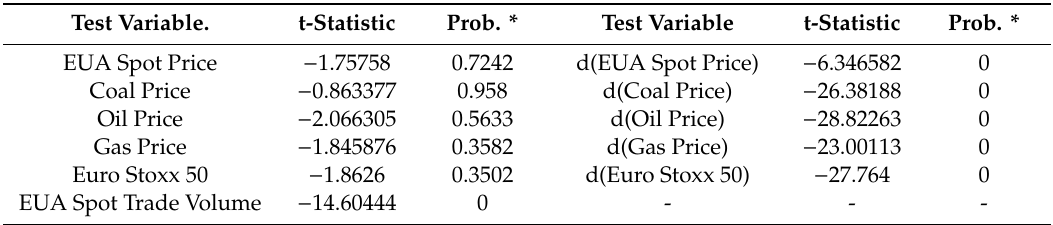
Table 1 . The augmented Dickey–Fuller (ADF) test results for European emission allowances (EUA) spot price and its external factors.